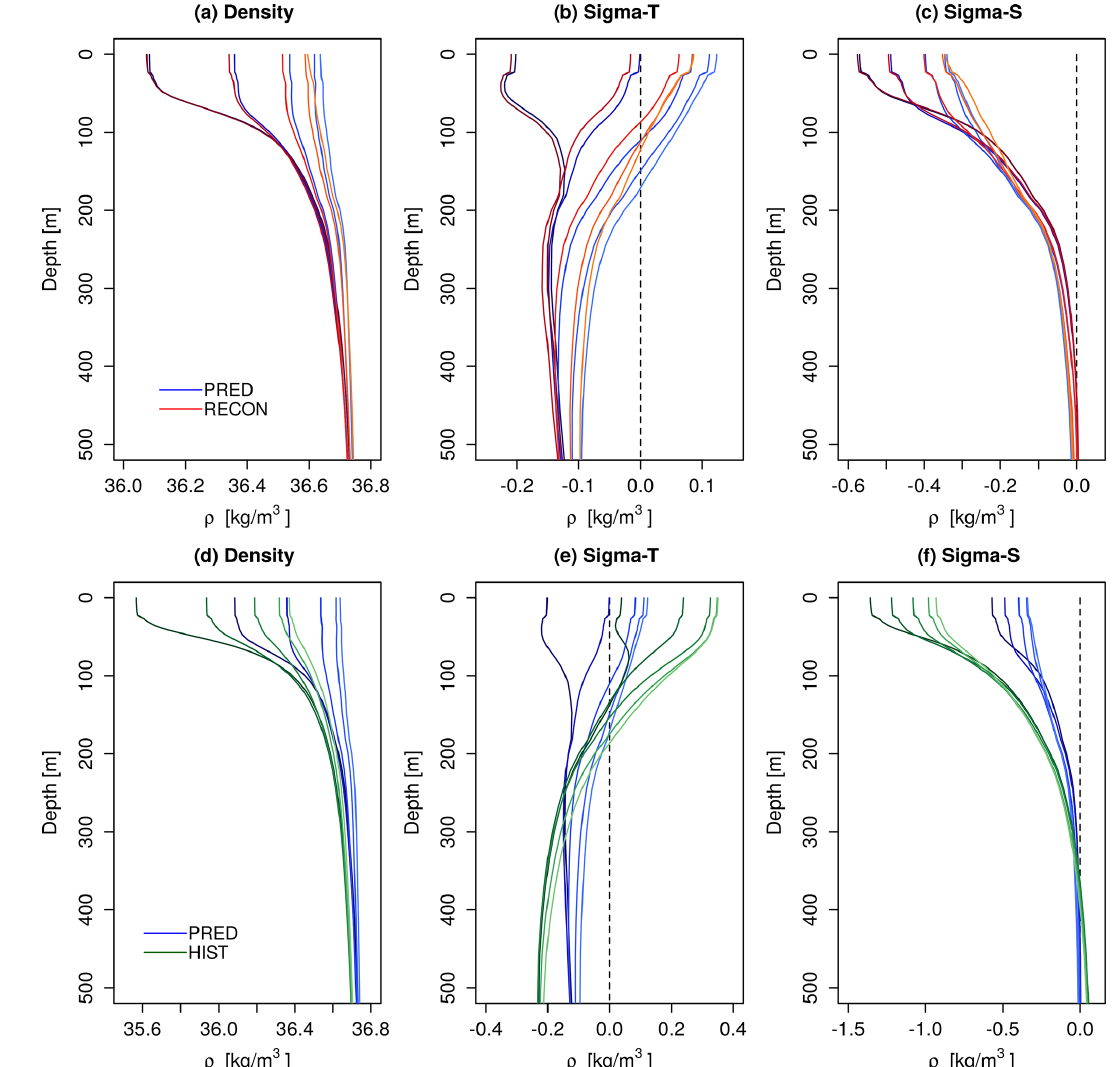
Figure 8. Labrador Sea (a) density, (b) sigma- T and (c) sigma- S climatological profiles in the first 5 forecast months (November–March) of PRED, and the equivalent calendar months of RECON. Panels (d–f) are the same as in panels (a–c) but for PRED and HIST (different panels are used to increase visibility). The colour intensity of the profiles from dark to light refers to increasing the forecast